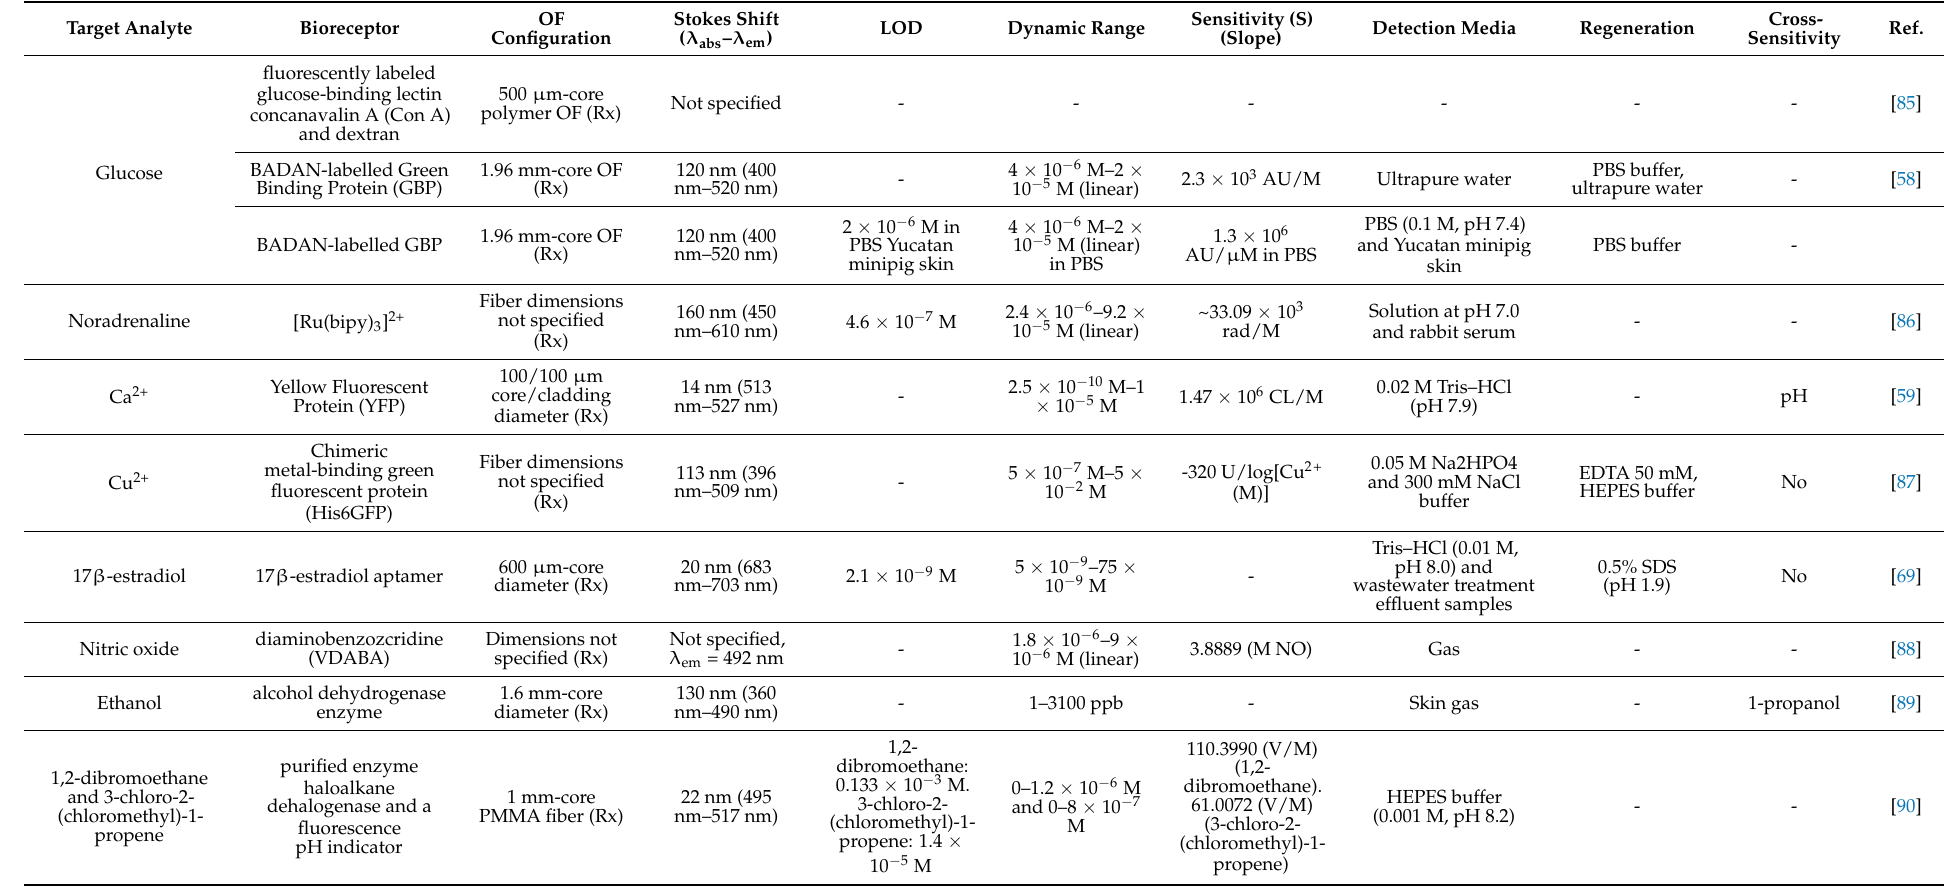
Table 4. Optical fiber biosensors based on luminescence using bioreceptors different from DNA strands, aptamers and antibodies. The dash indicates that information about that parameter is not available in the original